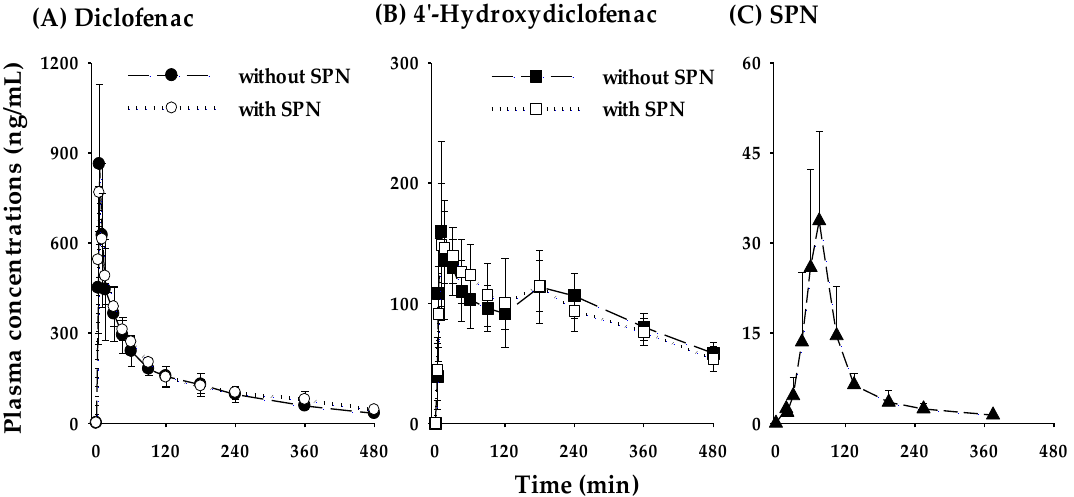
Figure 6. Mean plasma concentrations of diclofenac ( A ) and 4′ -hydroxydiclofenac ( B ) after oral administration of diclofenac at a dose of 2 mg/kg without ( ●, n = 6) or with ( ○ , n = 6) oral dosing of SPN (75 mg/kg) to rats. Mean plasma concentrations of SPN ( C ) after co-administration of SPN (75 mg/kg) and diclofenac (2 mg/kg) to rats ( ▲ , n = 6). Vertical bars mean standard deviation.